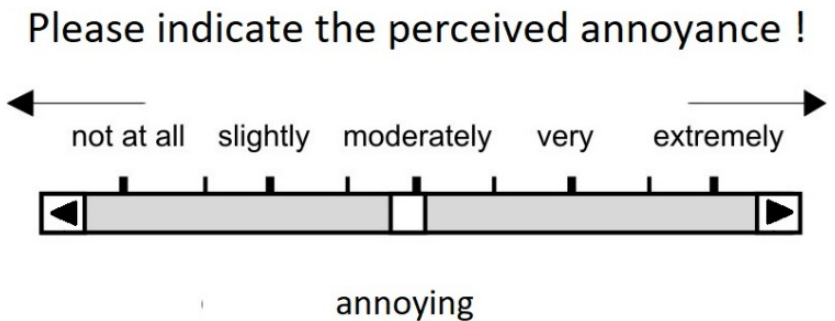
Figure 2. Rating scale used in this study.